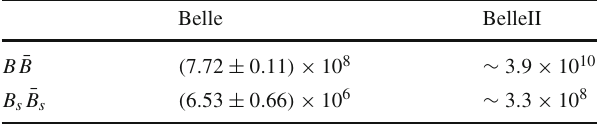
Table 2 The total numbers of B ¯ B and B + s B − s pairs from Belle collab- oration, while BelleII will have the data samples of 50 times as large as Belle by the mid of next decade. The number of B ¯ B and B s ¯ B s pairs for Belle collaboration are from Refs.